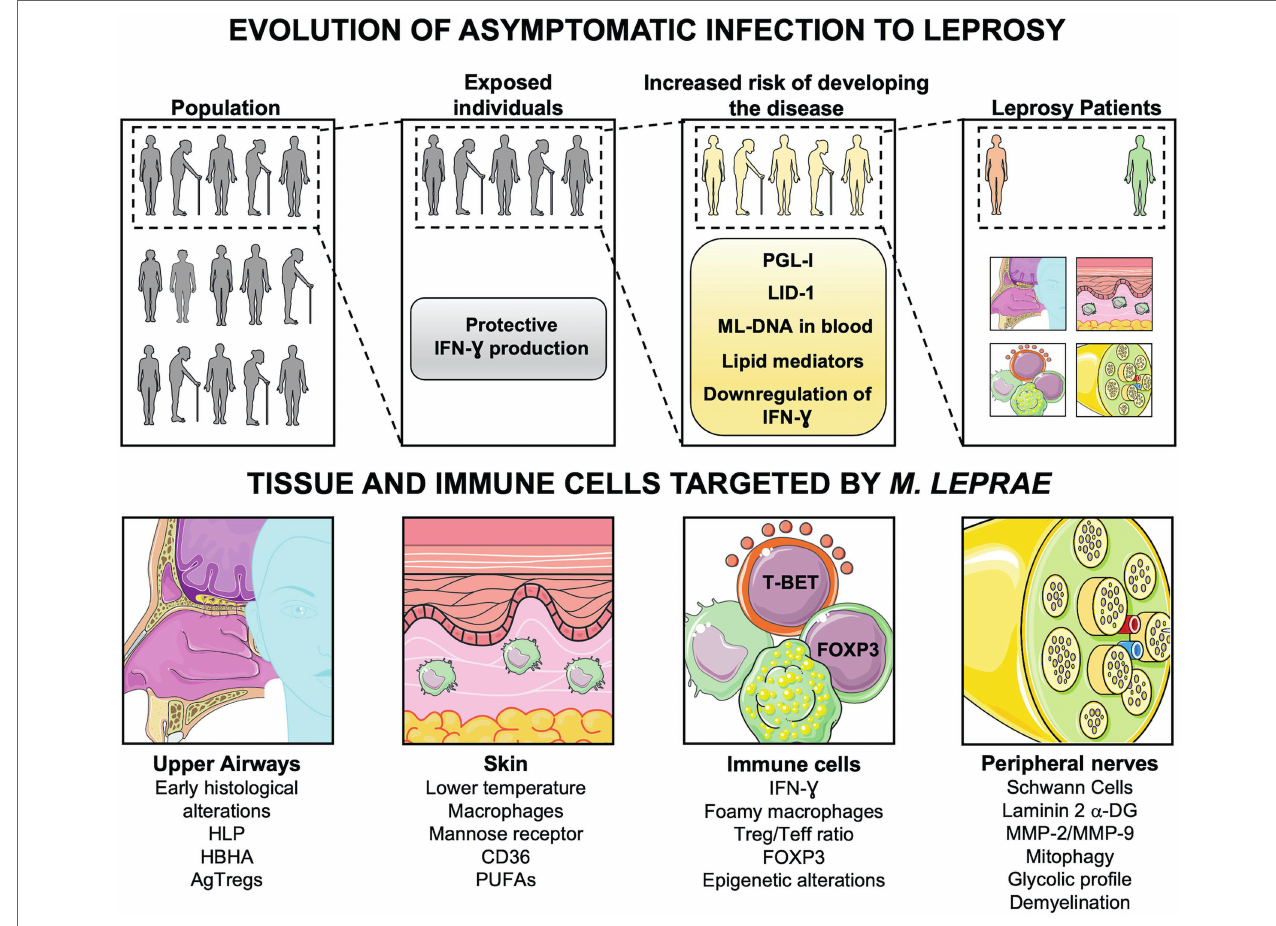
FIGURE 1 | Evolution of asymptomatic infection to active disease. Following exposure to Mycobacterium leprae , only a few people develop Leprosy. The progression to active disease is accompanied by immunologic and metabolic changes, such as downregulation of TH1 cytokines, production of antibodies (anti- PGL-I and LID-1), and lipid mediators. DNA of M. leprae in blood samples also indicates individuals with an increased risk of disease onset. Leprosy patients may present alterations in upper airways, skin, and peripheral nerves, depending on the host immune cells involved in the response against M. leprae . DNA-ML, DNA of M. leprae ; PGL-I, Phenolic Glycolipid I; LID-1, leprosy IDRI diagnostic-1; RvD1, Resolvin D1; PGE 2 , Prostaglandin E 2 ; PGD 2 , Prostaglandin D 2 ; LXA 4 , Lipoxin A 4 ; HLP, Histone-like protein; HBHA, hemagglutinin binding heparin; AgTregs, antigen-specific regulatory T cells; PUFAs, Polyunsaturated fatty acids; Teff, effector T cells; Laminin 2 α -DG, Laminin 2 α Dystroglycan; MMP-2, matrix metalloproteinase-2; MMP-9, matrix metalloproteinase-9. Created with